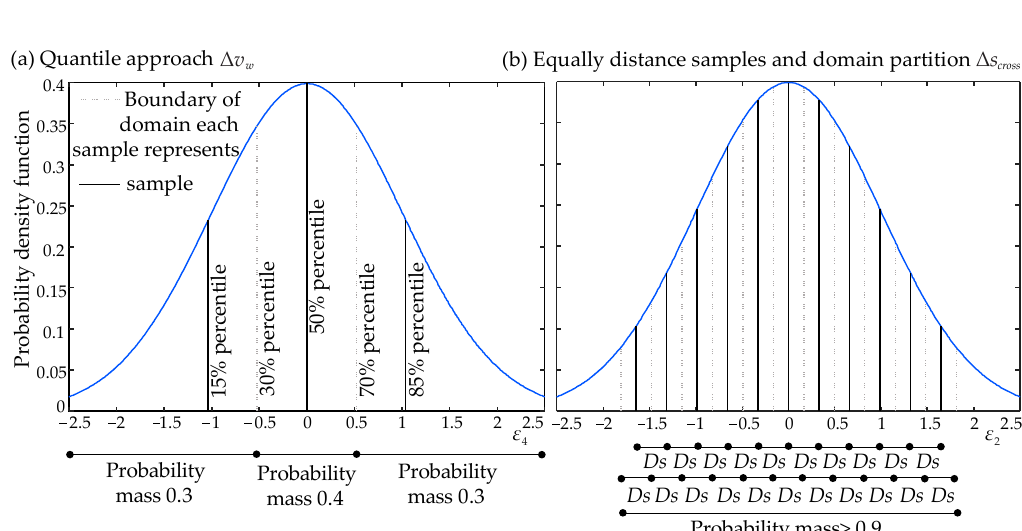
Figure 3. Illustration of the sampling process from a standard normal distribution using: ( a ) probability mass approach (shown for w v ) or ( b ) equally spaced samples and domain partition for ∆ cross s .